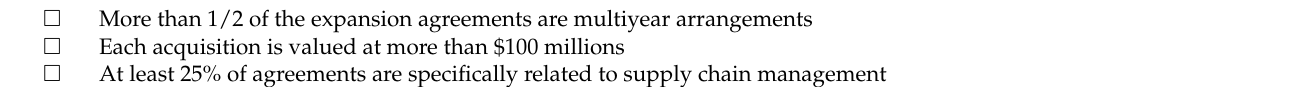
Table 4. By the numbers: scale and impact of foreign firms’ activities.